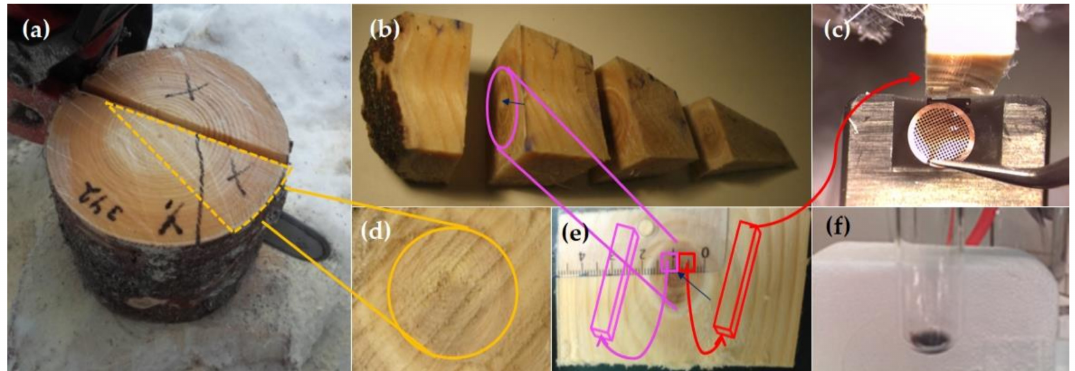
Figure 9. Tree sampling, knotwood preparation and a chemical reaction between HMR and OsO4. ( a ) A stem wood disc with knotwood inside the stem. A sector including knotwood was sawn (marked in yellow). ( b ) A 3 cm thick knotwood disc was taken 2 cm from the bark. Blue arrow shows the knotwood pith. ( c ) An ultramicrotome was used to cut the knotwood transverse surface. ( d ) Transverse cutting surface of a branch base. ( e ) Knotwood sticks (pink and red) were cut above and close to the knot pith (marked with a blue arrow). ( f ) Reaction of HMR with